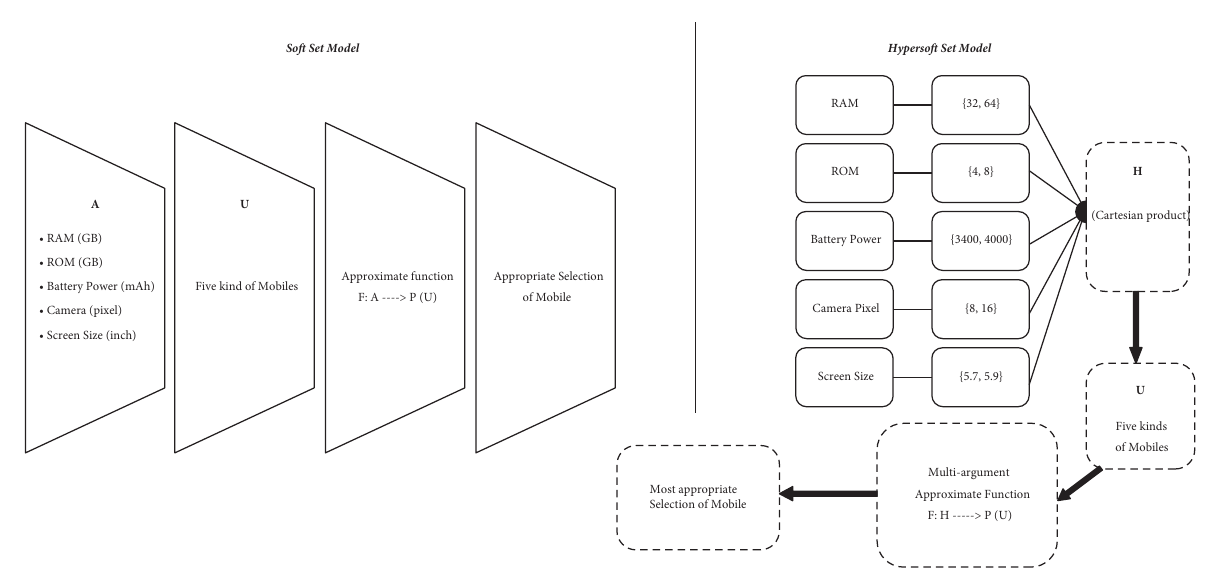
Figure 1: Comparison of soft set and hypersoft